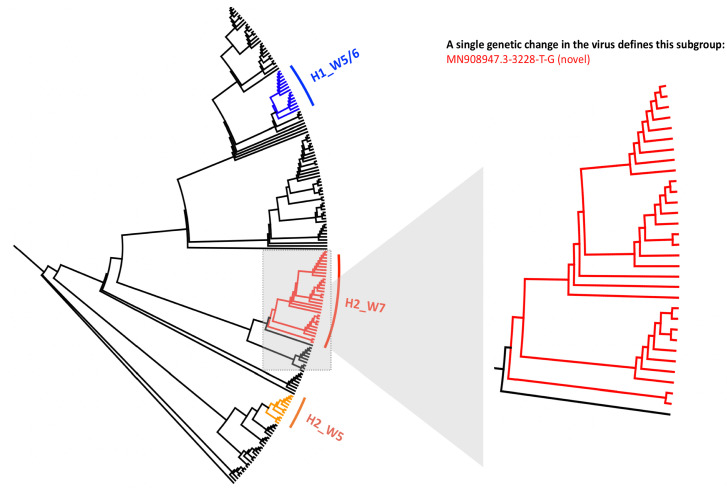
Local phylogenetic tree created for 173 SARS-CoV-2 genomes sequenced across Manchester University Hospital Foundation Trust.The tree is rooted to the MN908947.3 SARS-CoV-2 genome and shows three clusters of genome sequences that are predominantly composed of viral samples taken from the same hospital wards. A zoomed in version of the tree is shown for the cluster predominantly composed of samples from a single ward (Hospital_2, Ward_7), showing 20 samples from this ward that all contain the same novel genomic variant MN908947.3–3228 T-G, and share significant genetic similarity to one another. The numbers indicated on nodes in Figure 1 refer to the order of sample placements in the presented phylogenetic tree, with samples ordered incrementally from MN908947.3.